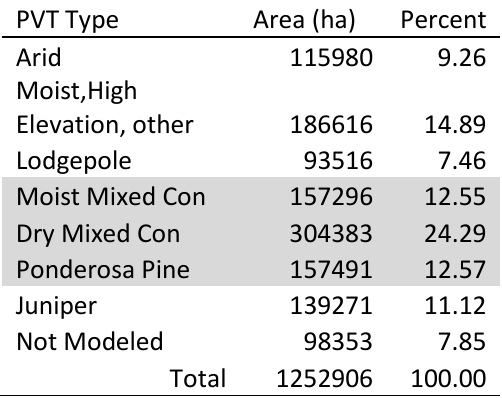
Table 2.2. Names and description of forested PVTs and classification into PVT management